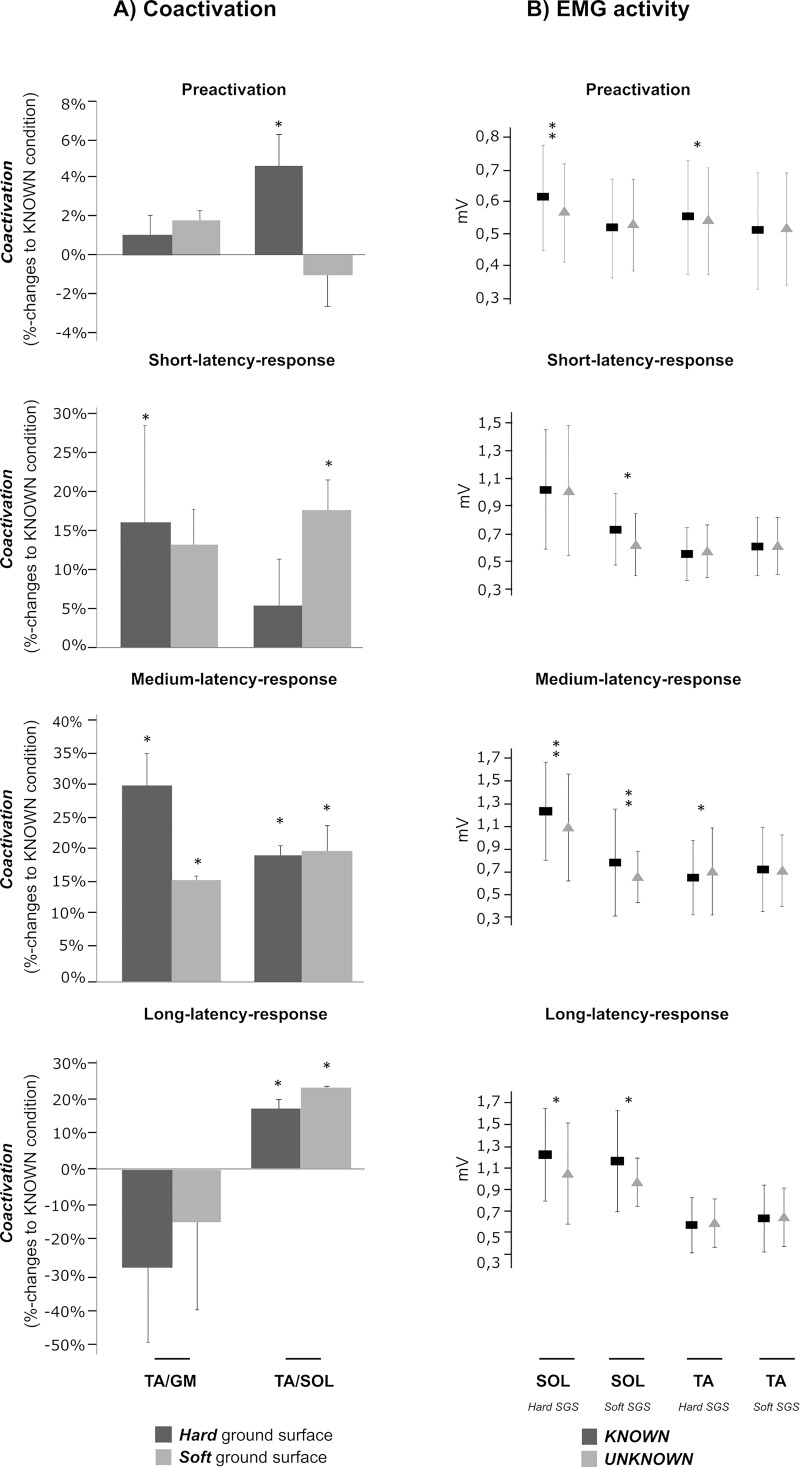
Comparison between changes in antagonistic co-activation in the shank musculature to measured EMG activity.(A) Percentile changes in antagonistic co-activation in the shank musculature, expressed as percentage changes to the known conditions for the ratios m. tibialis anterior and m. soleus (TA/SOL) and m. gastrocnemius medialis (TA/GM), respectively (hard ground displayed in dark columns, soft ground displayed in lighter grey columns). From top to bottom, the graphs demonstrate the results for: PRE (-150-0 ms prior to ground contact), SLR (30–60 ms), MLR (60–90 ms) and LLR (90–120 ms) phases. Significant results are marked with an asterisk (* for P < 0.05; **for P < 0.001). (B) Changes in grand means in SOL and TA are expressed as differences between known and unknown conditions in respect to the SGS (hard and soft). The dark squares display the grand means with standard deviations of the known condition; the triangles display the grand means of the unknown condition. From top to bottom, the graphs demonstrate the results for: PRE, SLR, MLR and LLR phases. Significant results are marked with an asterisk (* for P < 0.05; ** for P < 0.001).